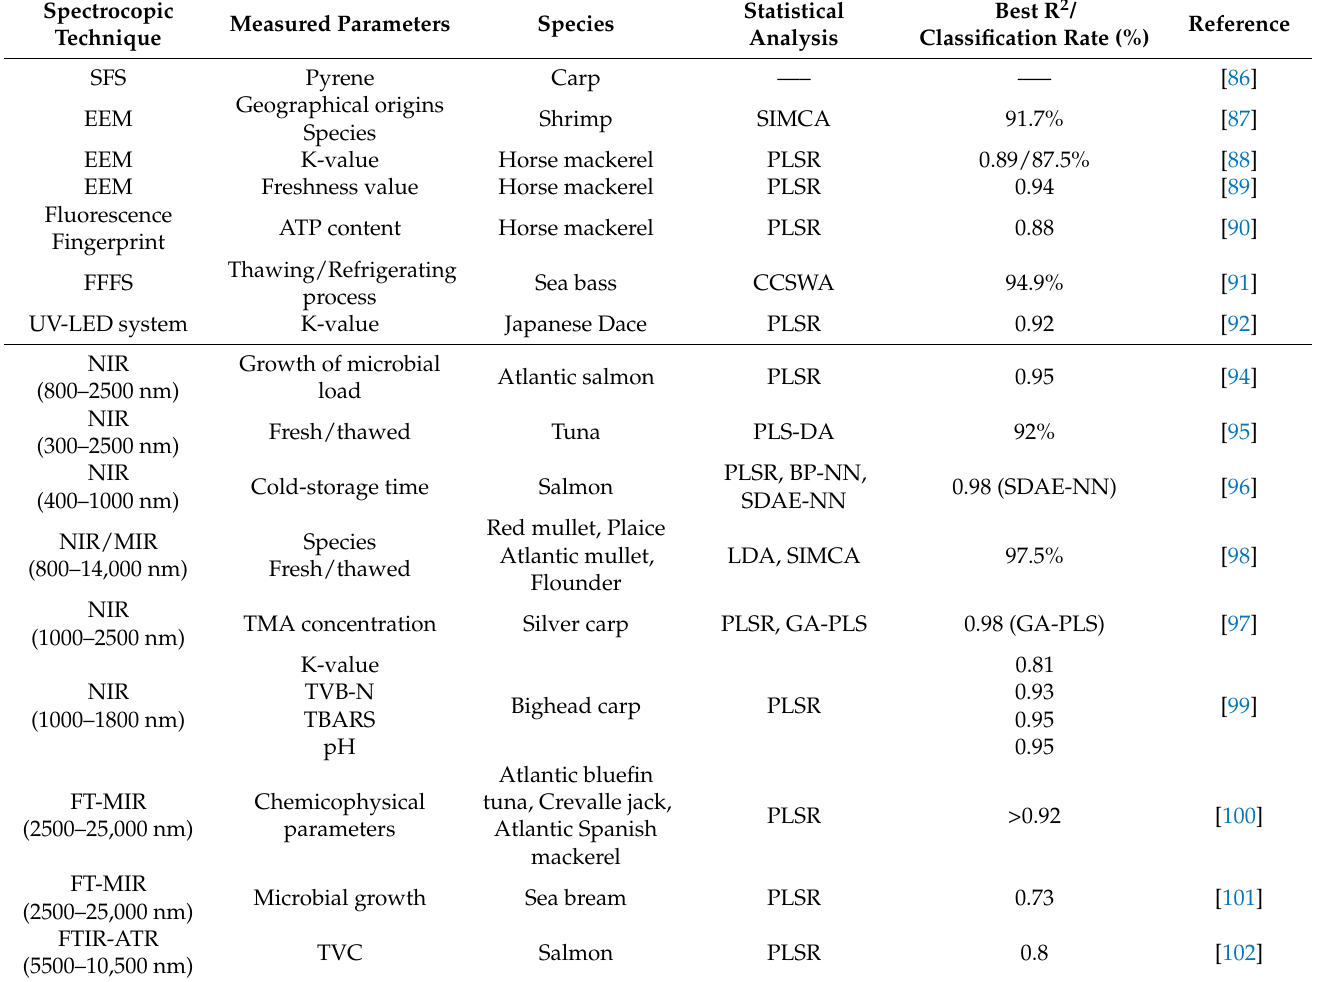
Table 5. Spectroscopic